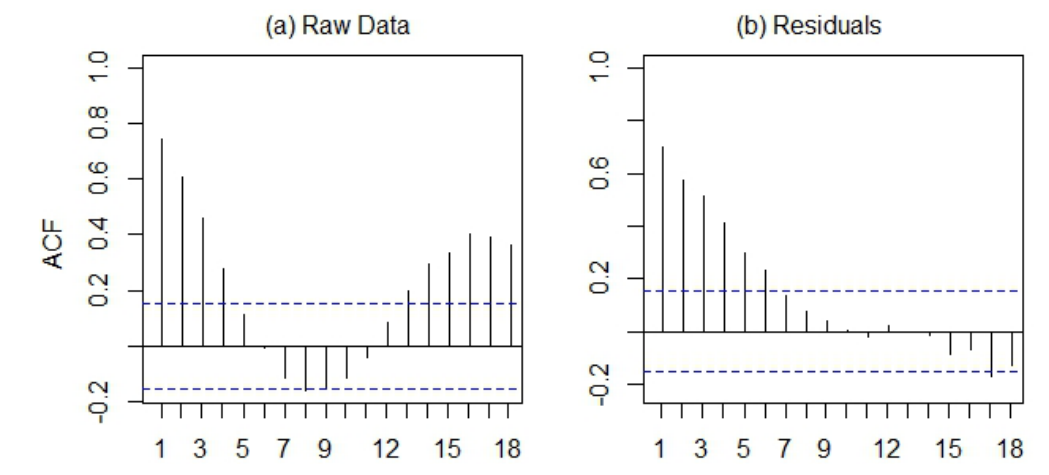
Figure 7. Temporal autocorrelation function for ( a ) the raw, log-transformed time series of WNV cases and ( b ) the remainders from the time series decomposition. Blue lines represent critical values for statistical significance of the autocorrelation statistic at an alpha-level of